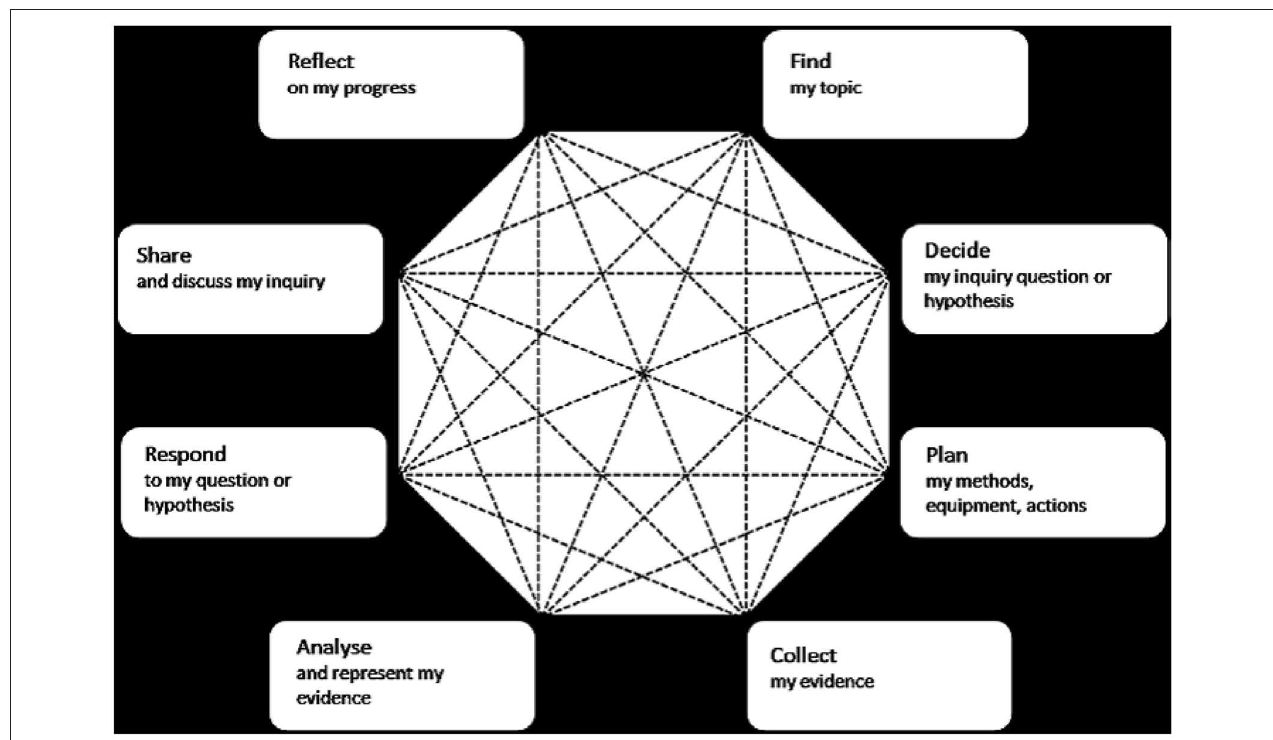
FIGURE 3 | A representation of an Inquiry Learning framework- one of the mediating artifacts and boundary objects used during the personal inquiry project (see also in Sharples et al., 2015, p.